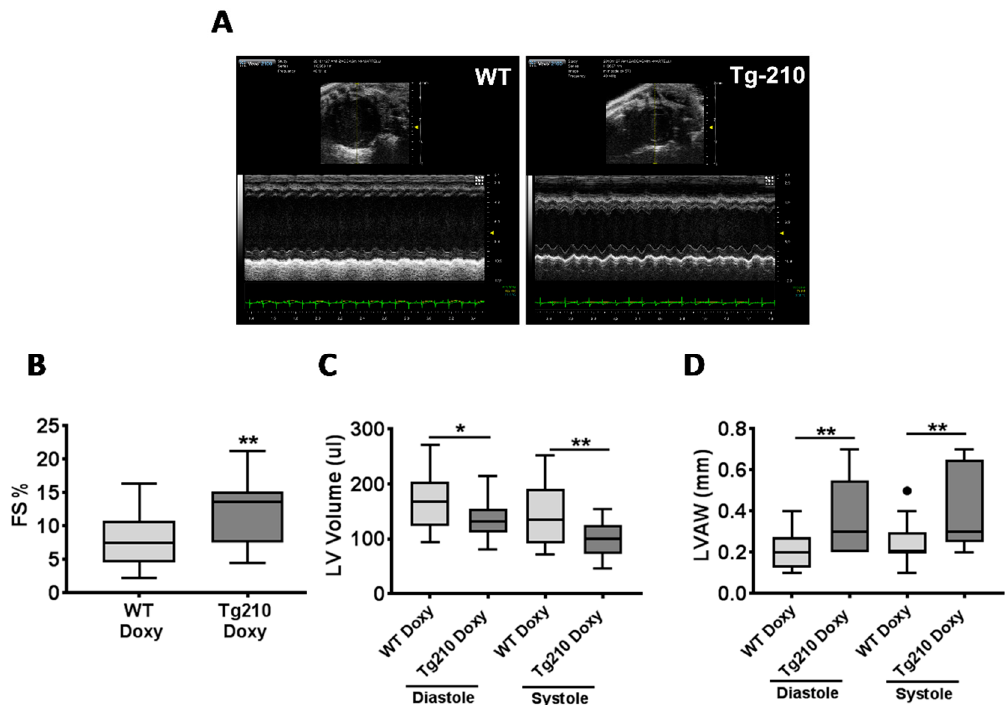
Figure 3. MiR-210 expression enhances cardiac function after myocardial infarction (MI). M-mode echocardiography is shown. ( A ) Representative parasternal short axis views of the LV, 1 month after MI in WT Doxy e Tg210 Doxy mice. The box plots represent ( B ) The percentage of fractional shortening (FS %) ( n = 18–20 ** p = 0.008); ( C ) The left ventricular volume (LV volume) ( n = 18–20; * p = 0.02, ** p = 0.008); ( D ) The left ventricular anterior wall (LVAW) ( n = 18–20; ** p ≤ 0.006), of WT Doxy and Tg210 Doxy hearts. Dark spot indicates an outlier.